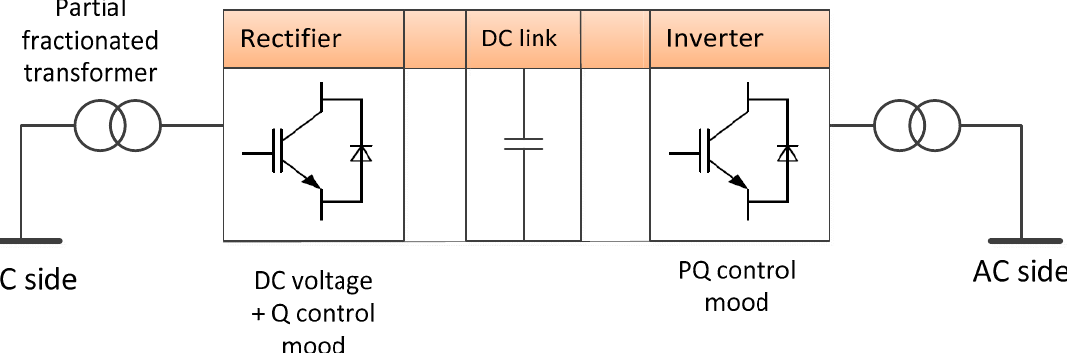
Figure 5. The overall PE design structure of the Voltage Source Converter (VSC) in the DC side.